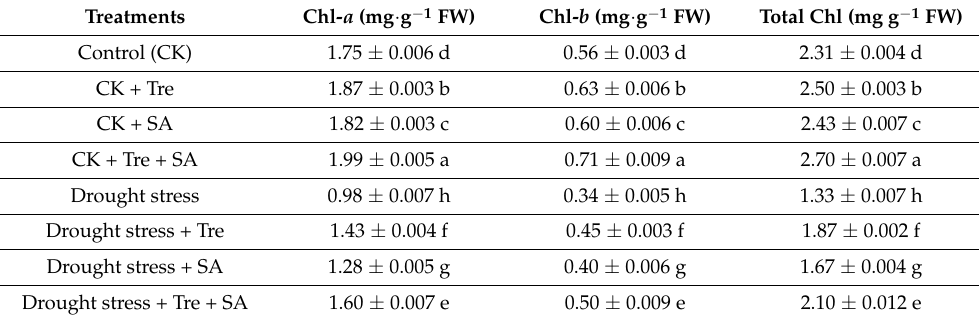
Table 1. Effect of foliar application of 30 mM trehalose (Tre) and/or 1 mM salicylic acid (SA) on chlorophyll a (Chl- a ) and b (Chl- b ), as well as total chlorophyll (Chl), concentrations in sweet basil seedlings grown under well-watered (control) and drought stress conditions. Values are the means ± SE ( n = 6). Different letters within a column indicate significant differences among means according to Duncan’s multiple-range test at the p < 0.05